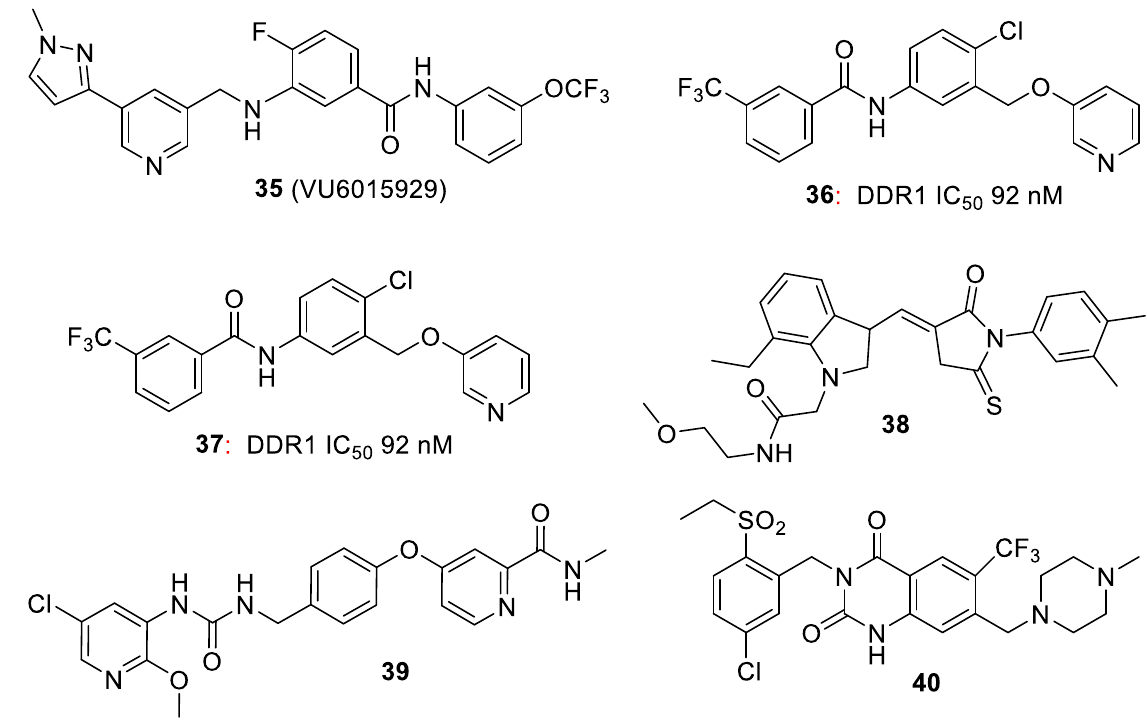
Figure 8. DDR inhibitors for inflammatory conditions.